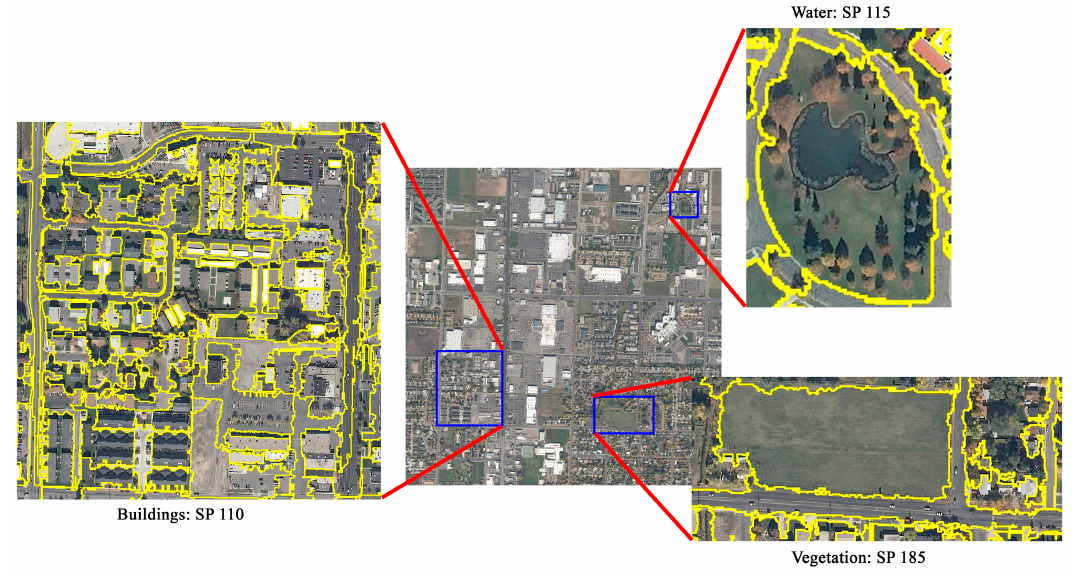
Figure A1. Segmentation results of the building, vegetation, and water classes in the 25-cm test image.